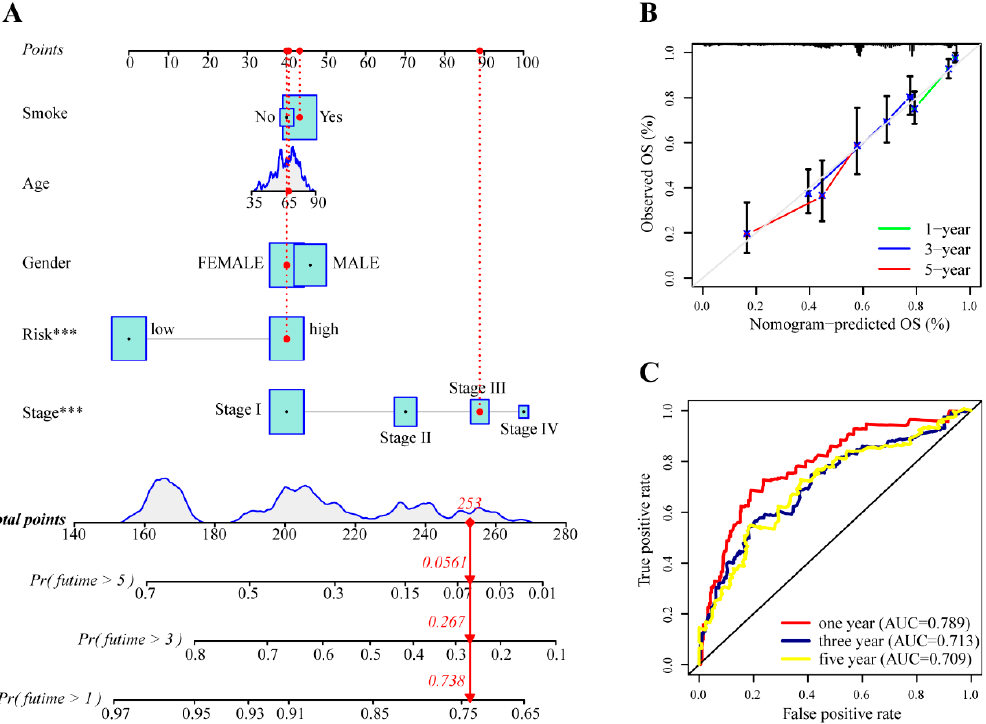
Figure 5. Integrated nomogram combining the risk score with clinical variables. ( A ) The visualization of overall survival prediction with risk score and clinical variables in the nomogram (*** p < 0.001). ( B ) The calibration curves of the nomogram. ( C ) ROC curves of the nomogram.